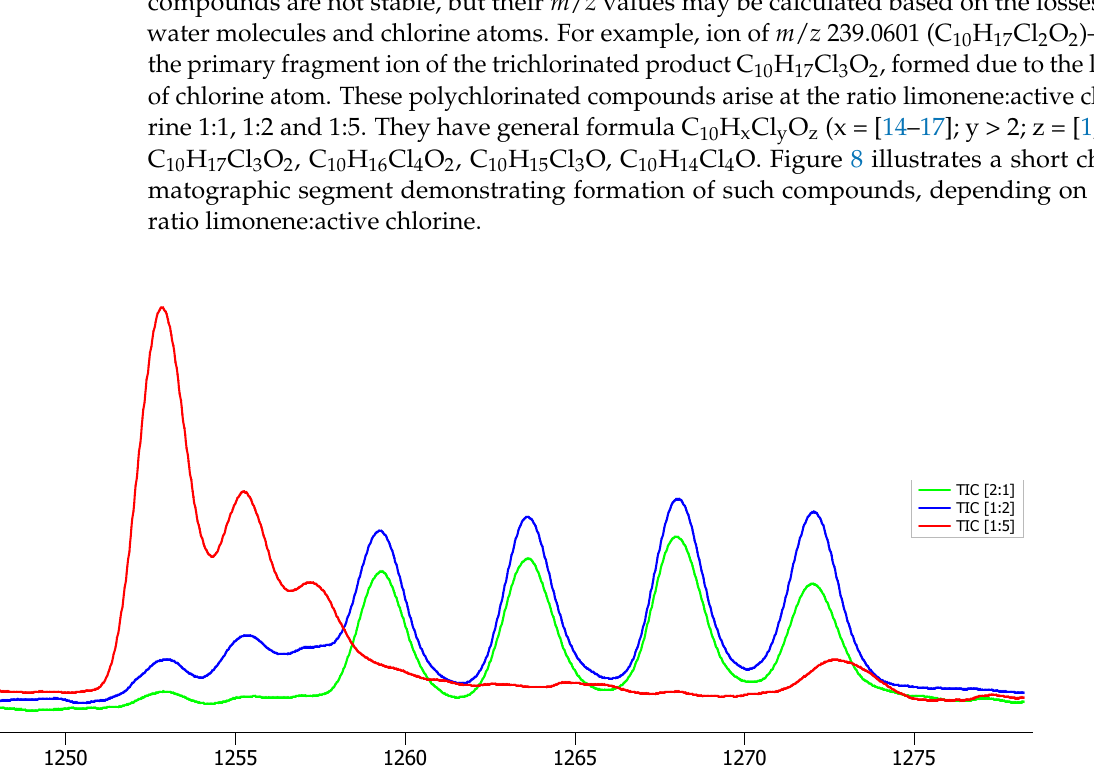
Figure 8. TIC chromatogram of the polychlorinated products of limonene aqueous chlorination de- pending on the ratio limonene/active chlorine: [2:1], [1:2], and [1:5].